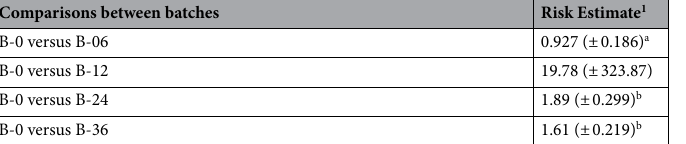
Comparisons between